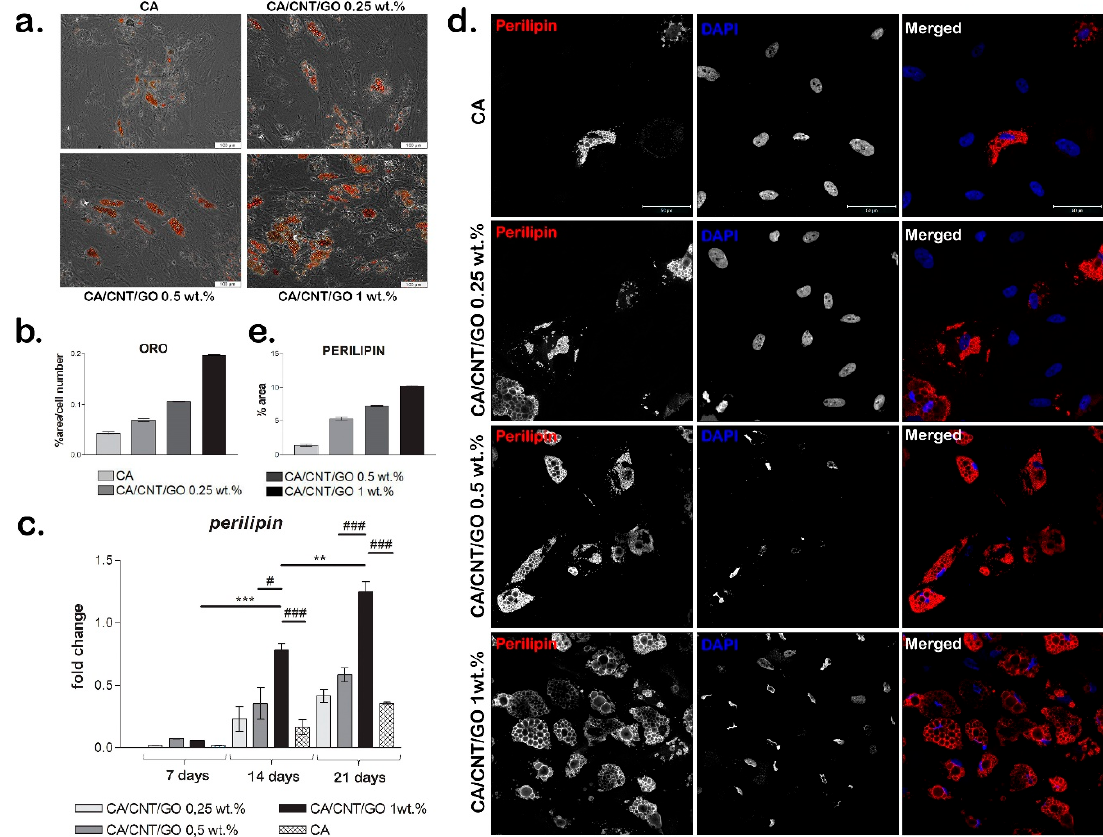
Figure 4. Evaluation of hASCs adipogenic differentiation on CA-CNT-GO materials: ( a ) Oil Red O staining for lipid droplets, scale bar 100 µm; ( b ) quantification of the Oil Red O staining normalized to cell number; ( c ) perilipin expression; Statistical significance: # p < 0.05; ** p < 0.01; *** /### p < 0.001; ( d ) immunofluorescence for adipogenic marker perilipin. scale bar 50 µm; and ( e ) quantification of the immunofluorescence staining of perilipin.